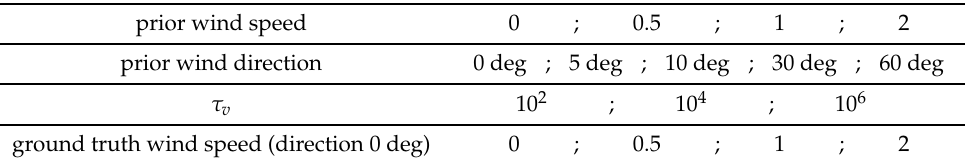
Table 3. Parameters used for analyzing the influence of the wind prior (Note: for the case prior wind speed 0 the wind direction was not